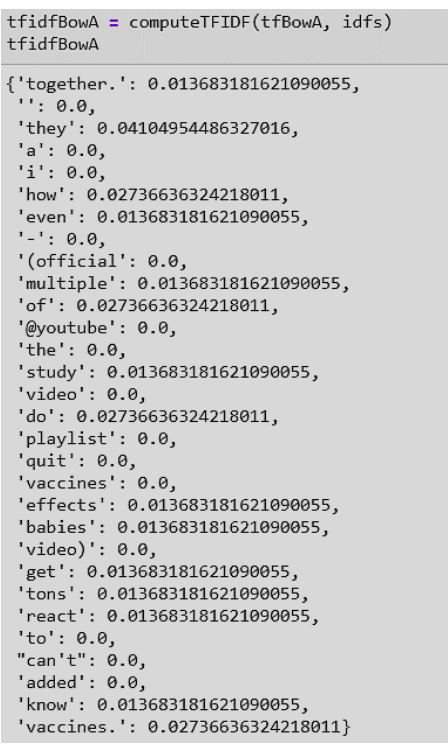
Figure 14. Example of the term frequency–inverse document frequency (TF-IDF) score from Document 1 in the data set.